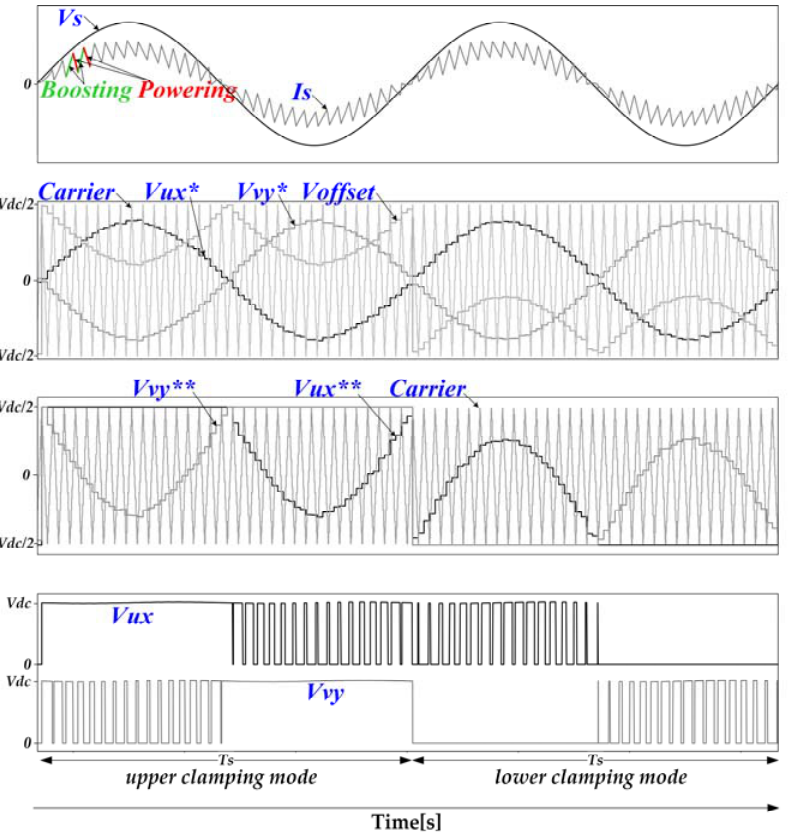
Figure 6. Main waveforms of single ‐ phase PWM converter using proposed DPWM (from Top, Vs , Is ; Carrier , Vux* , Vvy* , Vo ff set ; Carrier , Vux** , Vvy** ; Vux , Vvy ).